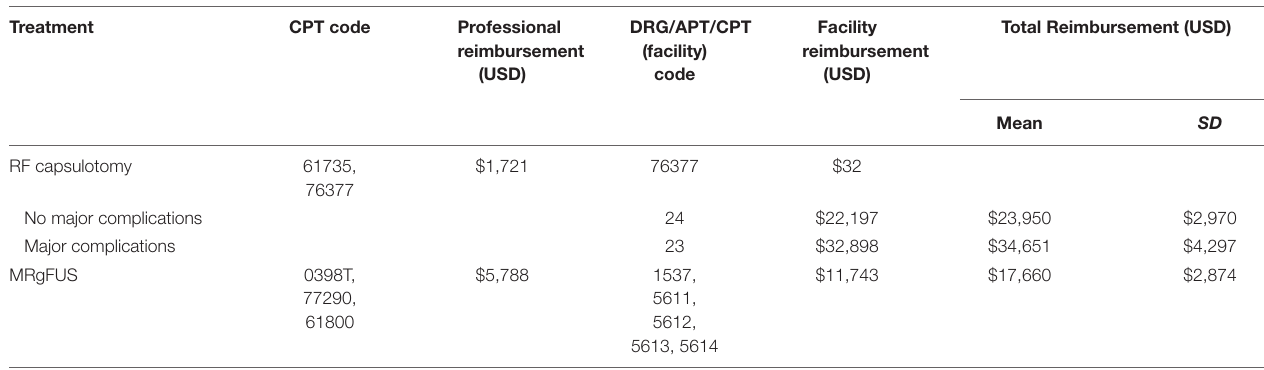
TABLE 2 | Costs (2017 USD) of RF Capsulotomy and MRgFUS for OCD.